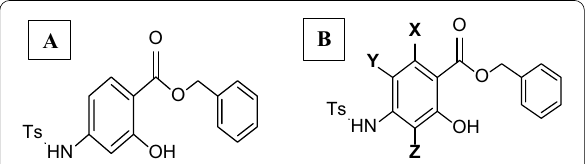
Fig. 3 A Structure of the lead compound. B Structure of the adopted